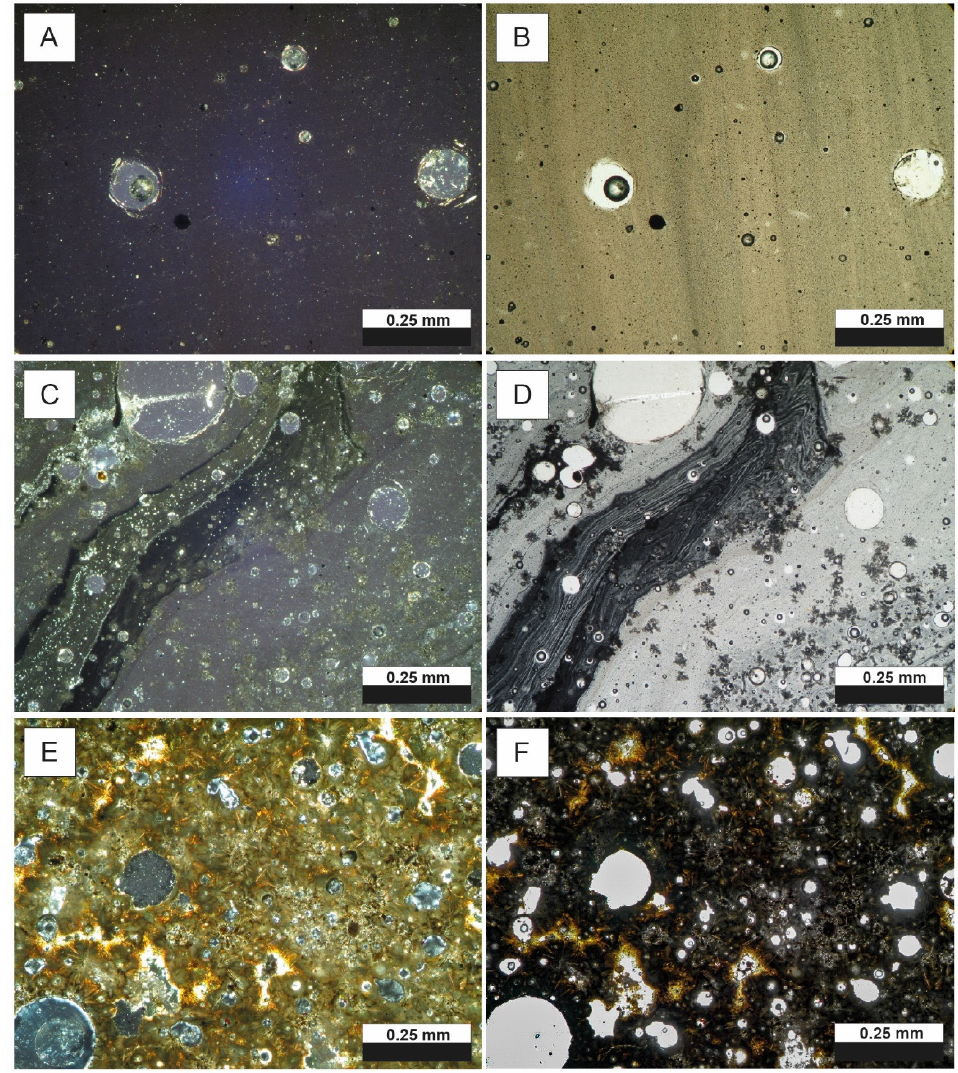
Figure 4. Microscopic images of slag samples in transmitted light in plane-polarized (left) and crossed-polarized light (right). ( A , B ) hyalite slags (glass and metallic phases (black)); ( C , D ) hypocrystalline slags (glass and crystalline phases); ( E , F ) holocrystalline slags (domination of crystalline phases).